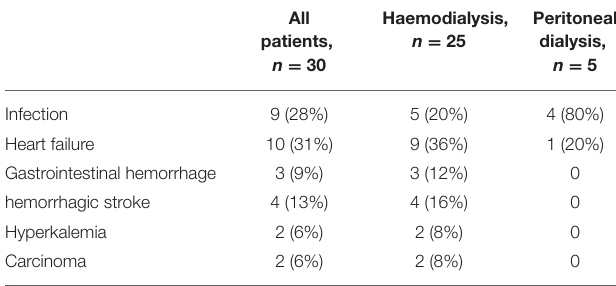
TABLE 2 | Causes of death in patients with AAV-ESRD.